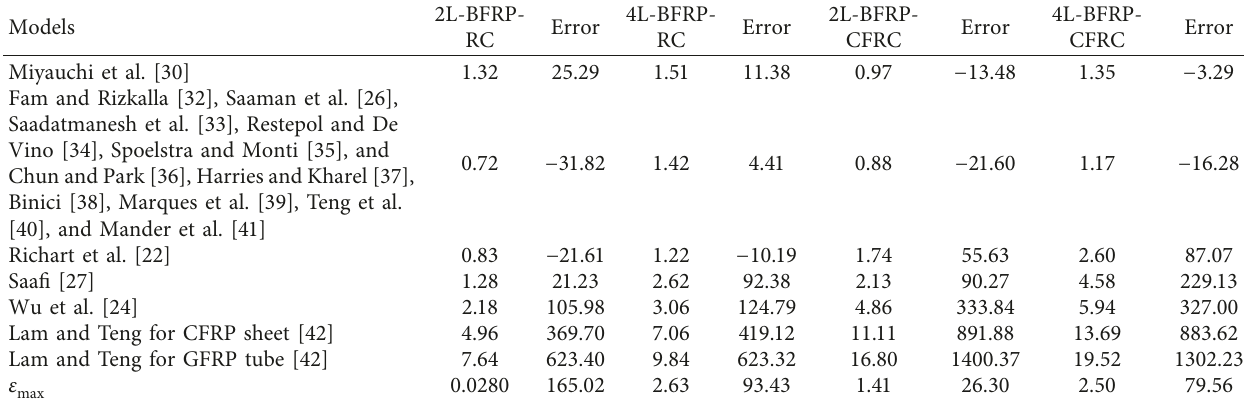
Table 9: Ultimate axial strain prediction of the large-size specimens (units: